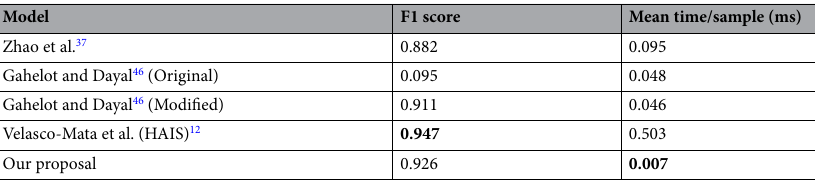
Table 3. Weighted F1 scores and mean time to process a sample. The traffic was processed in time windows of one second. The modified Gahelot and Dayal model refers to the feature vector in which we have excluded the IPs. Significant values are in bold.